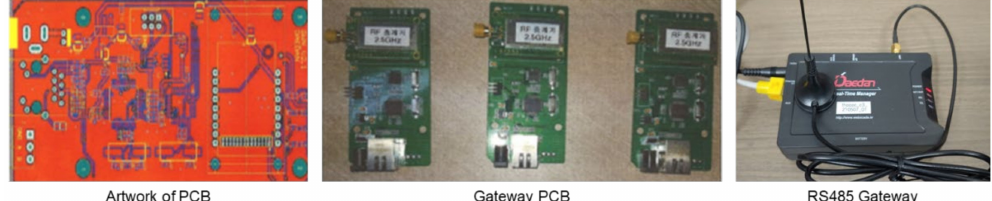
Figure 4. RS485 gateway for